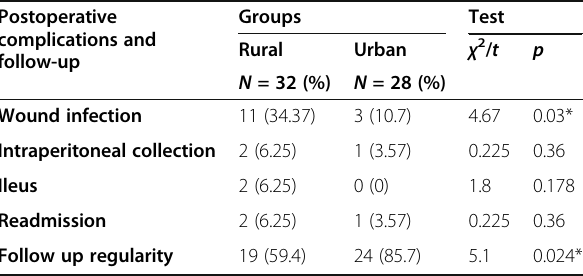
Table 3 Postoperative complications and follow-up Postoperative complications